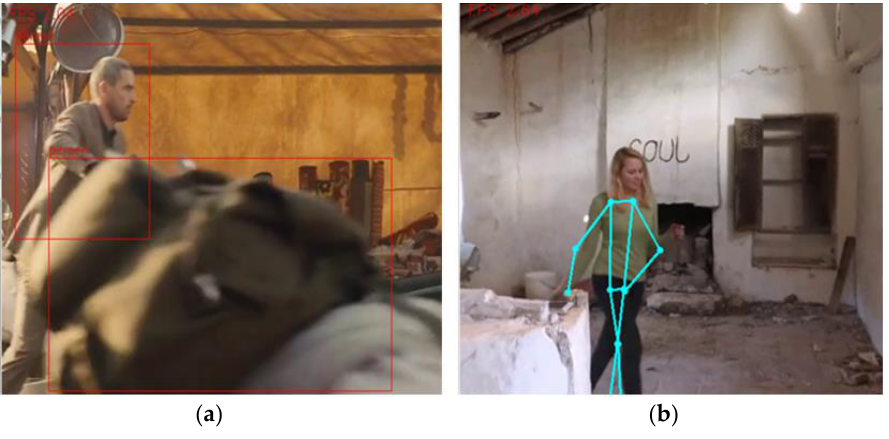
Figure 7. ( a ): Object Detection, ( b ): Pose Detection.